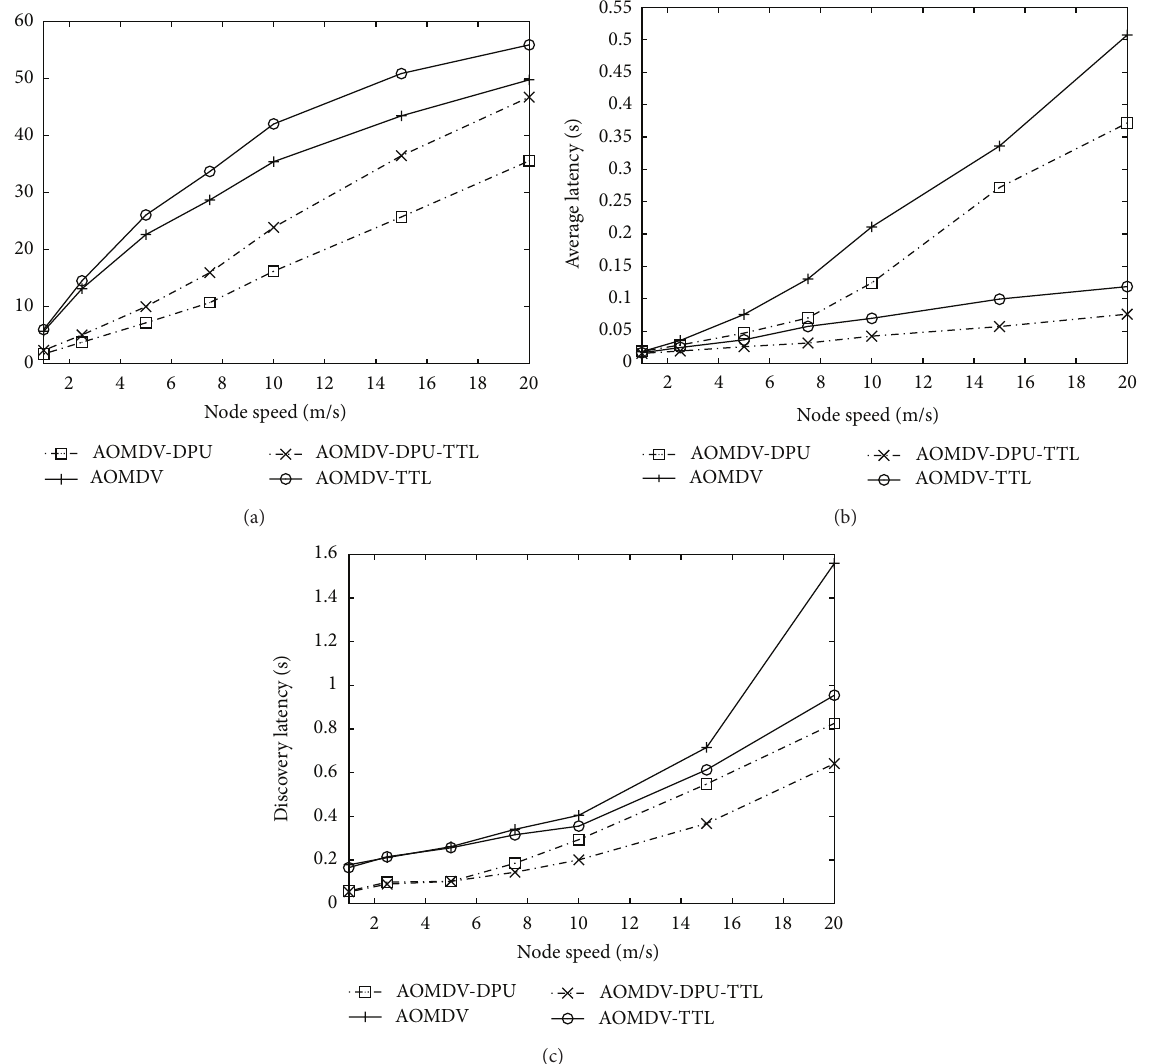
Figure 5: Performance with varying node speeds (a) packet loss, (b) average packet delivery latency, and (c) route discovery latency.